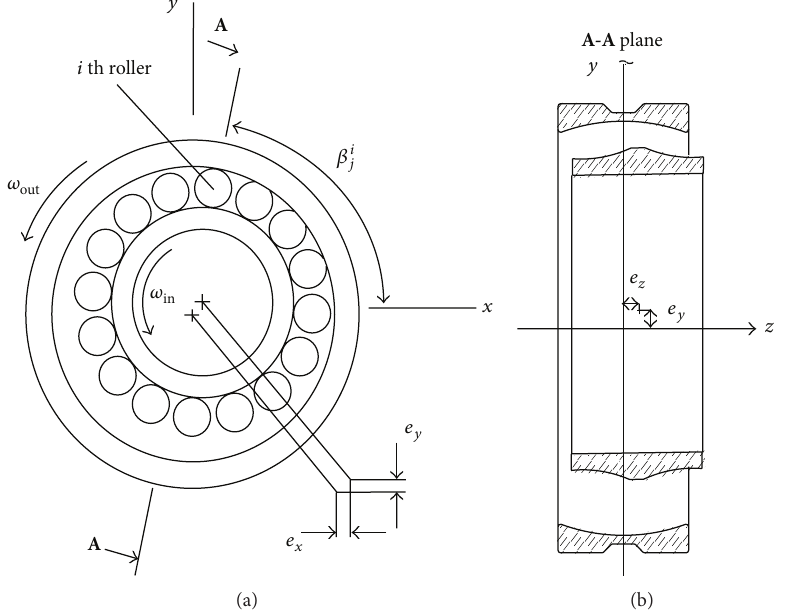
Figure 5: (a) Axial and (b) transverse cross-section in the A-A plane of spherical roller